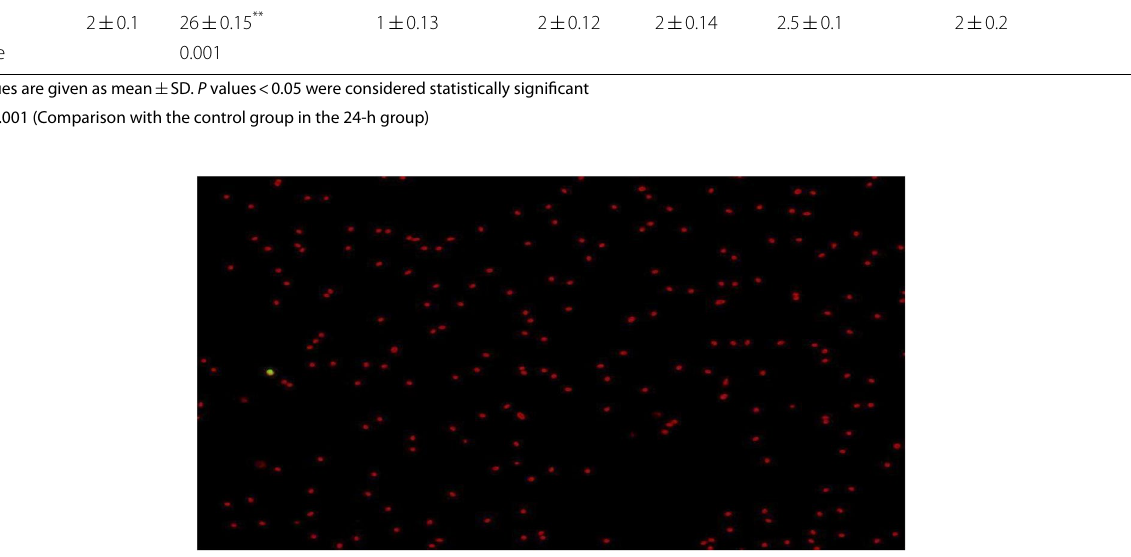
Fig. 2 The picture indicates DNA damage (green) and normal (red) human